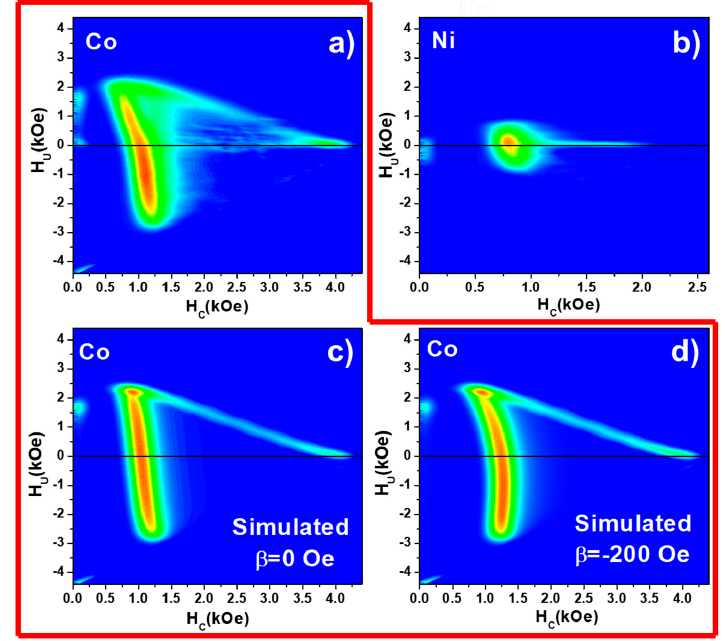
Figure 4. Experimental FORC diagrams of Co ( a ) and Ni ( b ) segment arrays measured along the nanowires axis. Simulated FORC diagrams for Co nanowire array with fixed experimental values of SFD and α , for β = 0 Oe ( c ) and β = − 200 Oe ( d ). Table 1. Values of the coercive field, H C , extracted from the major hysteresis loop and mean switching field, MFI at saturation ( α ) and standard deviation ( σ ) of the SFD extracted from FORC for Co and Ni nanowire segment arrays.